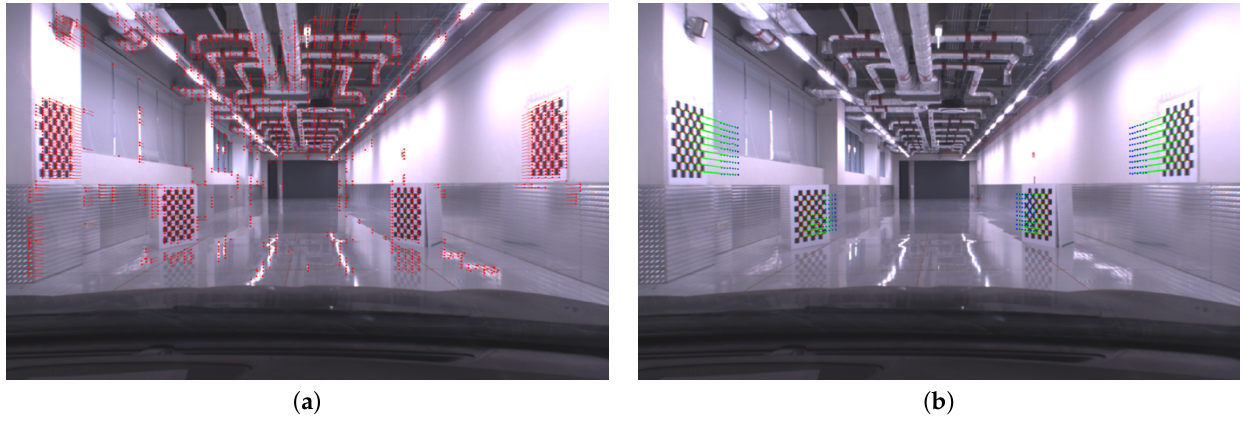
Figure 5. Real calibration environment: ( a ) optical flow of background features for estimating ego-motion of the vehicle. ( b ) Optical flow of chessboard features for 3d